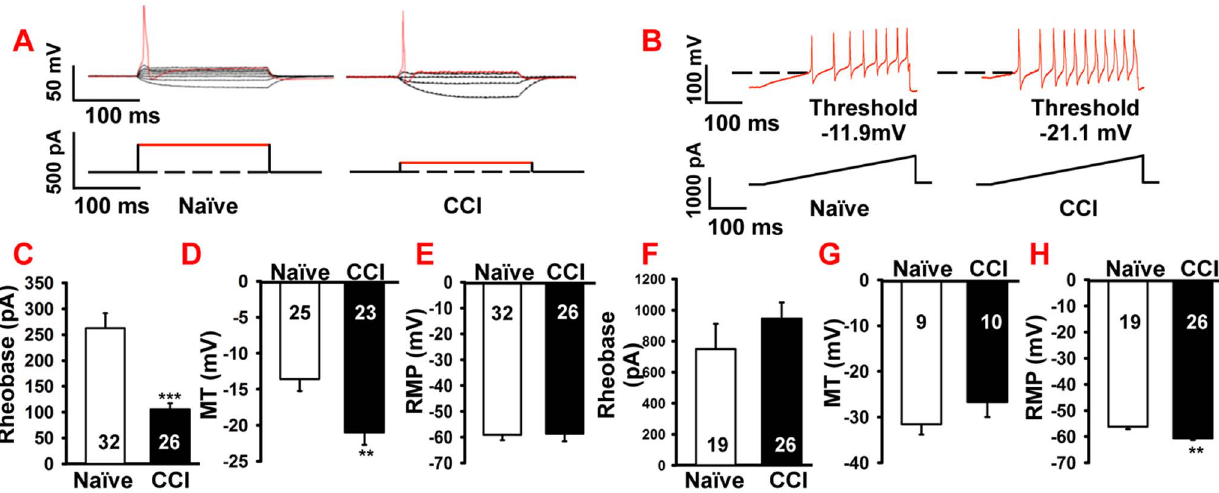
Figure 1. CCI of sciatic nerve increased small diameter neuron excitabilities, but had no effect on large diameter neurons. A. Current clamp recordings of the membrane potential (upper traces) and injected current (lower traces) from small diameter DRG neurons of naı¨ve and CCI animals, showing a lowered rheobase after CCI. B. Following CCI, small diameter neurons also exhibited a lowered membrane threshold (upper trace) during a ramp stimulus (lower trace). The dashed lines indicate a membrane threshold of 2 11.9 mV for the naı¨ve neurons and 2 21.1 mV for CCI neurons. Statistical analysis showed that CCI significantly reduced rheobase (C) and membrane threshold (D) compared to naı¨ve animals. No difference was found in resting membrane potential between naı¨ve and CCI animals (E). Large diameter neurons showed no difference in rheobase (F) or membrane threshold (G) between naı¨ve and CCI animals, but the CCI group had a lower resting membrane potential (RMP) compared with the naı¨ve group (H). Numbers in each column represents recorded neurons. MT: membrane threshold. Mean 6 SEM, ** p , 0.01, *** p ,